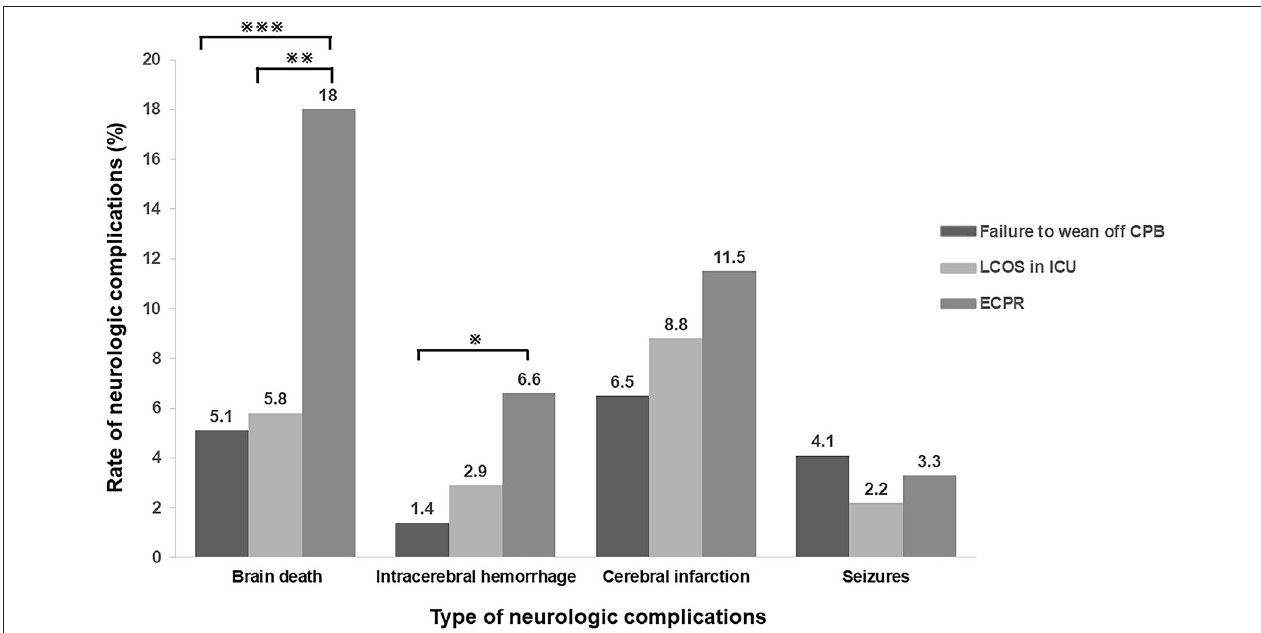
FIGURE 2 | Incidence of neurologic complications in different types of ECMO indications. ECPR patients had a higher rate of brain death, intracranial hemorrhage and cerebral infarction when compared with the patients with other indications. ( ※ P < 0.05; ※※ P < 0.01; ※※※ P < 0.005) CPB, cardiopulmonary bypass; LCOS, low cardiac output syndrome; ICU, intensive care unit; ECPR, extracorporeal cardiopulmonary resuscitation.